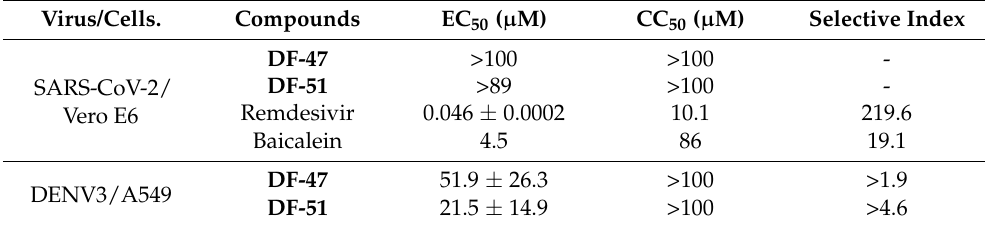
Table 3. Antiviral activity and cytotoxicity of polyphenols and positive controls. Virus/Cells.